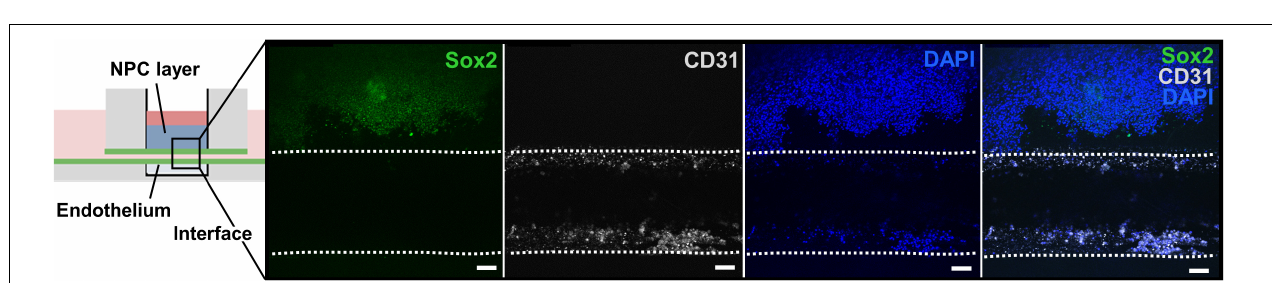
FIGURE 7 | Bioprinted tissue-on-chip with vascular-like channel. Schematic of the tissue-on-chip design. Confocal images of hiPSC-NPCs encapsulated within 3 wt% ELP-RGD bioprinted on top of a channel seeded with HUVECs and cultured for 5 days. hiPSC-NPCs were visualized with Sox2 immunostaining, HUVECs were visualized with CD31 immunostaining, and all cells were visualized by nuclear staining with DAPI. Scale bars represent 50 µ m.